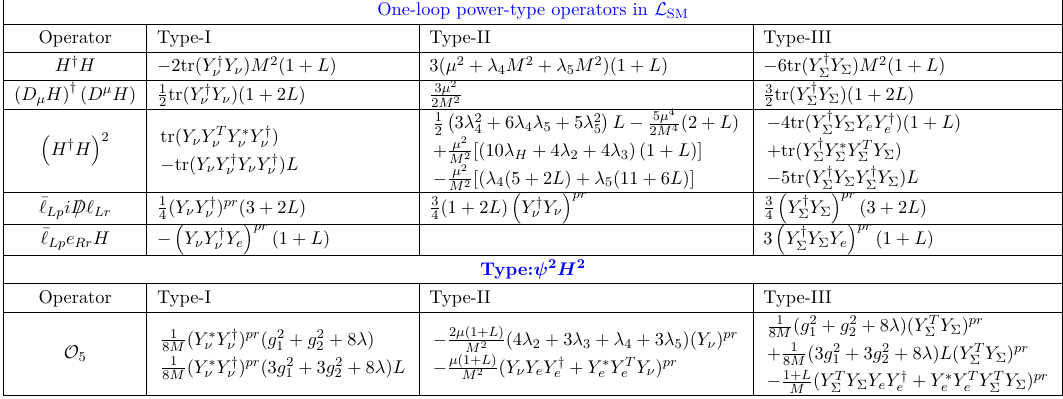
Table 3 . Power-type terms from one-loop matching in the Green’s basis. We only show the matching results for L and the Weinberg operator in this table. Higher dimensional power-type SM operators from one-loop matching can be found in following